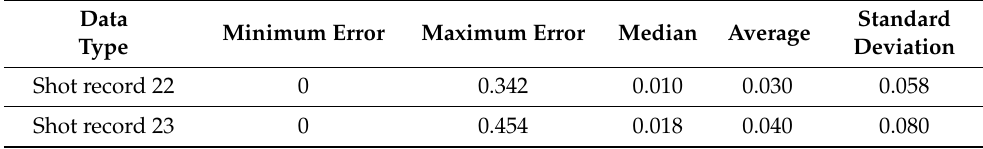
Figure 15. Absolute error between first arrival picks determined by the HEEH method and manually for Yilmaz record number 23. Table 2. Basic statistical parameters of the absolute error values (in seconds) for the real